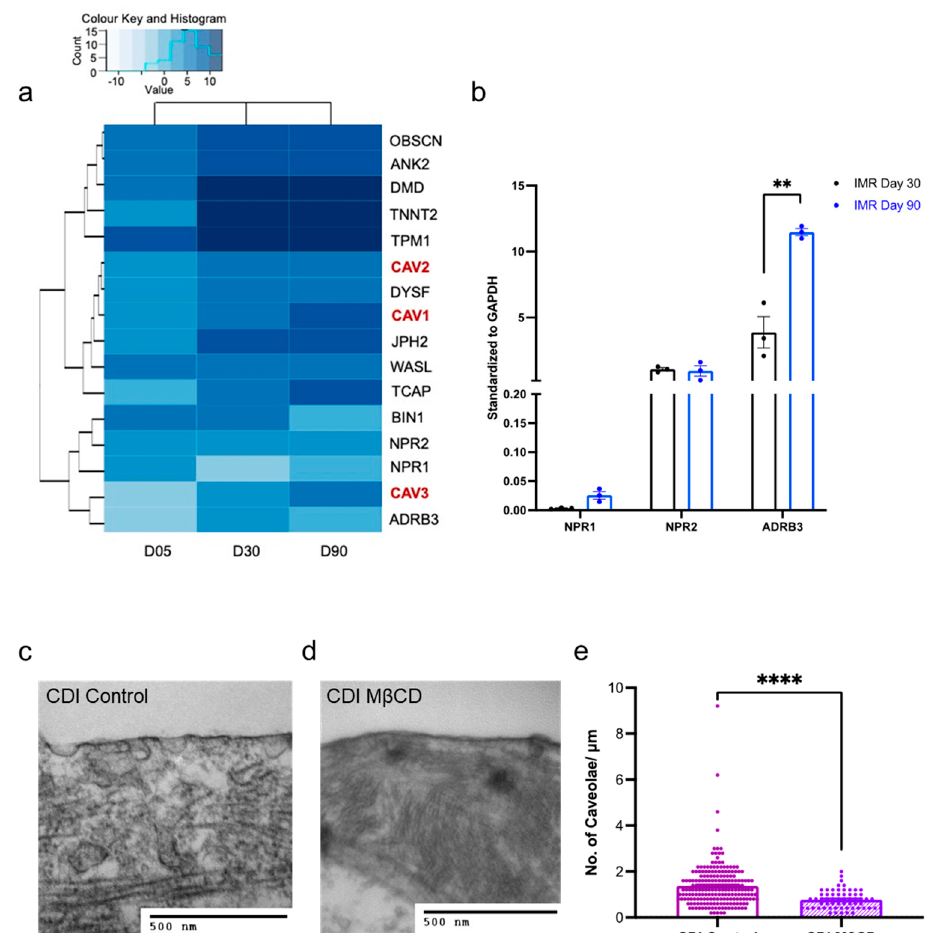
Figure 3. Expression of structural components in hPSC-CMs aged day 5, 30, and 90. ( a ) Heatmap of structural gene expression in IMR-hPSC-CMs aged day 5, 30, and 90. ( b ) Gene expression of Natriuretic peptide receptors (NPR) 1/2 and ADBR3 in IMR-hPSC-CMs aged day 30 and 90. Repre- sentative transmission electron microscopy (TEM) images of control ( c ) and methyl- β -cyclodextrin (M β CD) ( d ) treated CDI-hPSC-CMs. ( e ) Quantitation of caveolae per micrometre in CDI-hPSC-CMs. **—p < 0.01; ****—p < 0.0001.